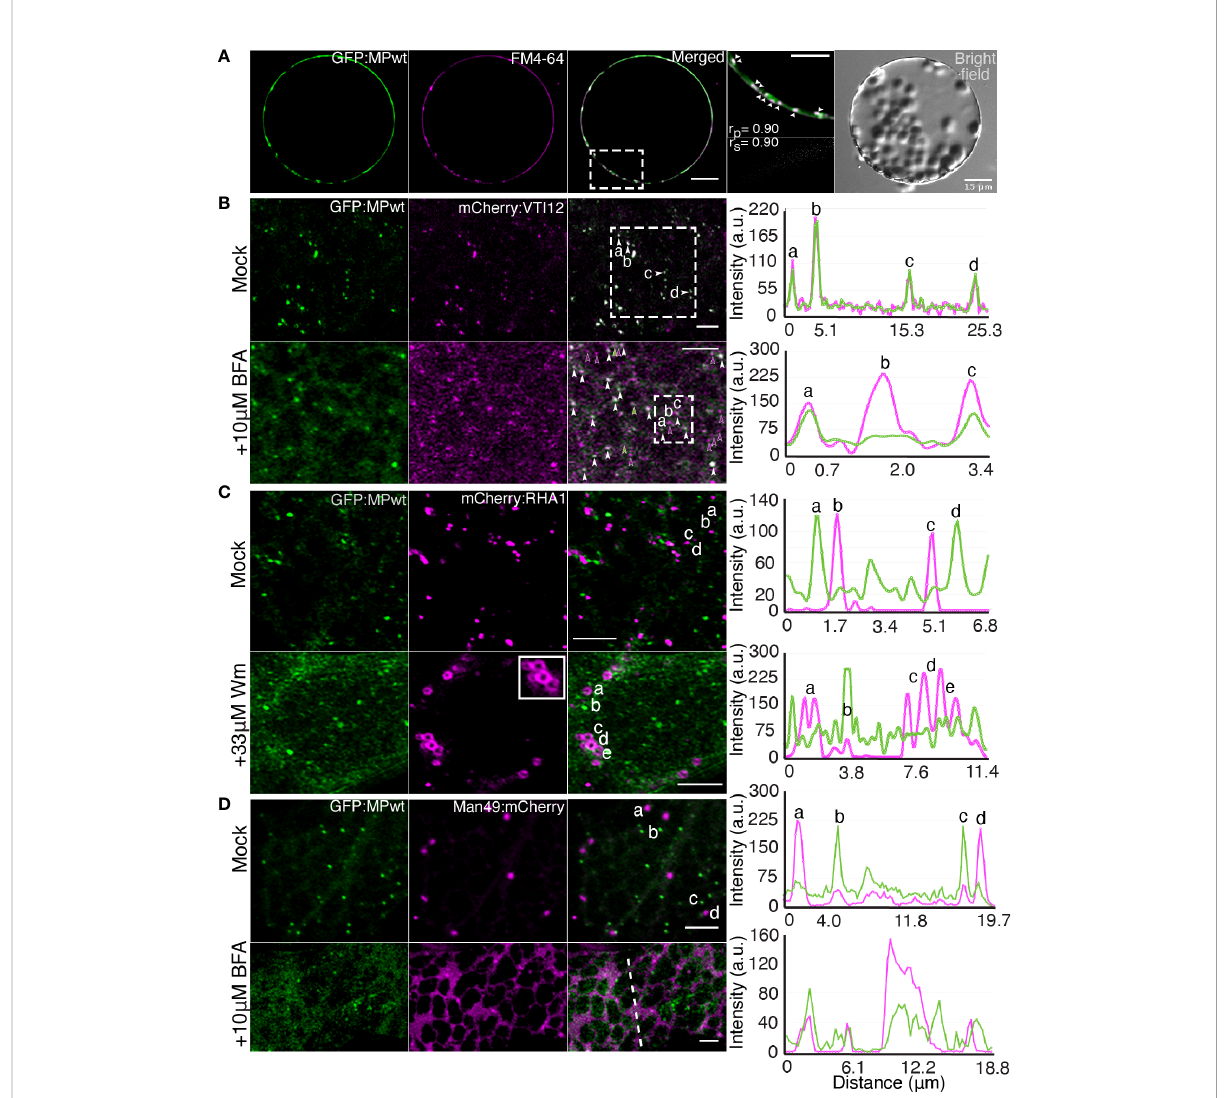
FIGURE 1 OuMV MP localizes to the TGN/EE, but not to the MVB/PVC or Golgi. (A) N. benthamiana protoplasts expressing OuMV GFP : MPwt (green) with RdRp and CP. Protoplasts were stained with FM4-64, an endocytic tracer (magenta). A selected region (white rectangle) was analyzed to show the colocalization of MP-labeled punctate structures (arrowheads) with FM4-64. The extent of colocalization was quanti fi ed using the PSC plugin in ImageJ. rp, linear Pearson correlation coef fi cient; rs, nonlinear Spearman ’ s rank correlation coef fi cient. Images represent single optical planes. Scale bars, 15 m m, 10 m m (magni fi ed region). (B – D) N. benthamiana epidermal cells expressing GFP : MPwt (green) with RdRp and CP, and organelle markers (magenta ) , (B) mCherry : VTI12 (TGN/EE), (C) mCherry : RHA1 (MVB/PVC) and (D) Man49:mCherry (Golgi). Cells were treated with 10 m M BFA (B, D, bottom panel) or 33 m M wortmannin ( C , bottom panel) for 1h. White arrowheads indicate colocalized spots, green and magenta arrowheads denote individual GFP : MPwt and mCherry : VTI12 spots, respectively. Images were taken at 66 hpi. Panels represent maximum intensity Z projections. Selected spots denoted by letters (B – D) and the signal along the line ( D , bottom panel) were analyzed to show the intensity pro fi le generated by ImageJ. Scale bars, 5 m